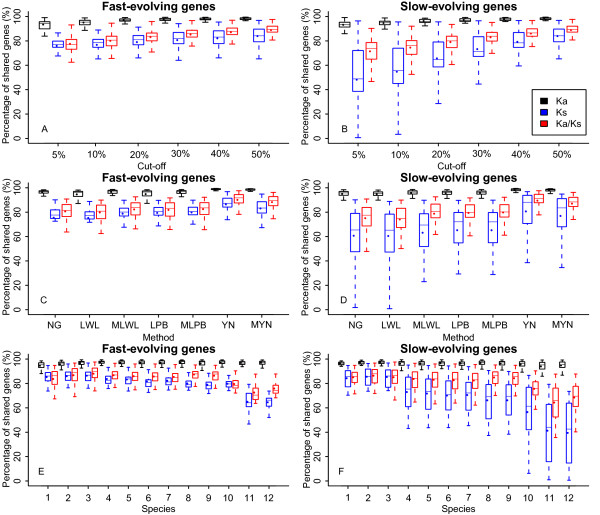
The percentage of shared genes of Ka, Ks and Ka/Ks based on GY compared with other seven methods in terms of cut-off (A, B), method (C, D), and species (E, F). Outliers were removed to make the plots straightforward. The number codes for the species are the same as what in Figure 1.